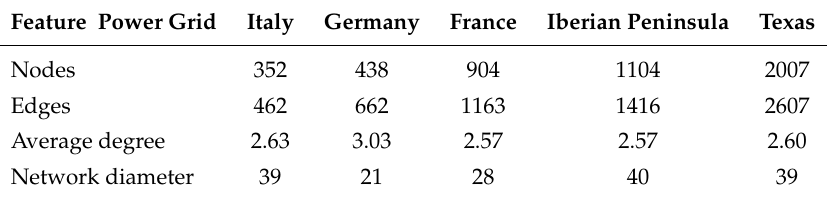
Table 1. Description of the graphs used to model the five power grids.